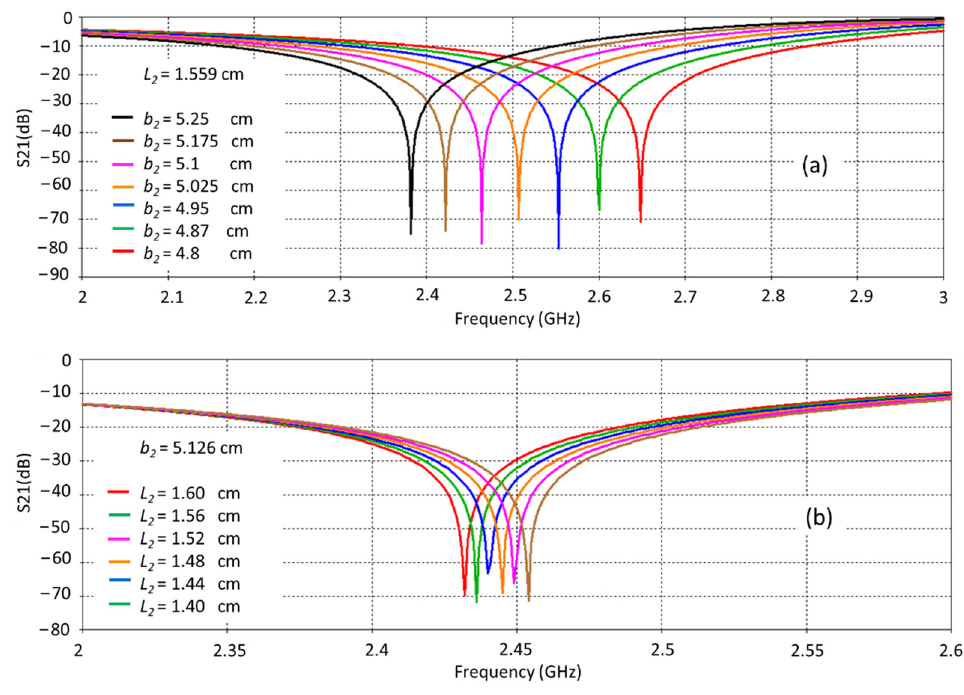
Figure 7. ( a ) Resonant frequency variation versus cavity inner radius. ( b ) Dependence on cavity height.